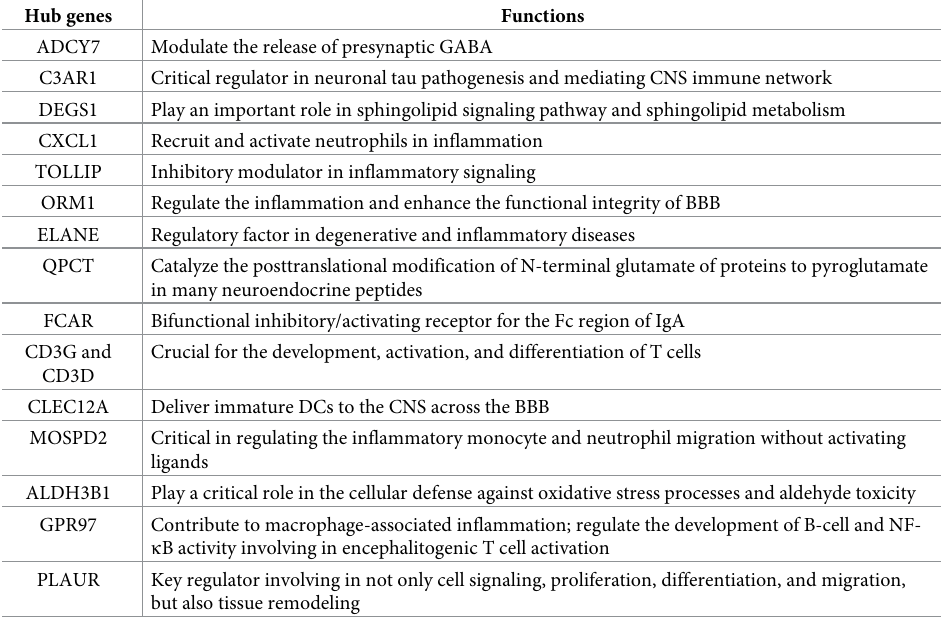
Table 3. Summary of functions of hub